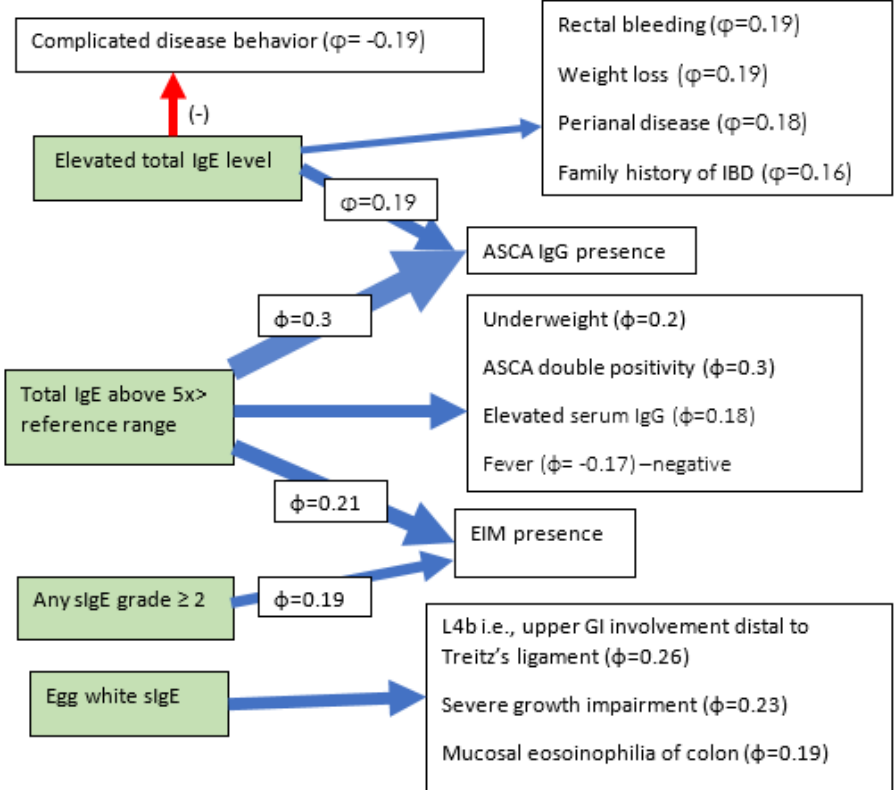
Figure 2. Correlations in CD.